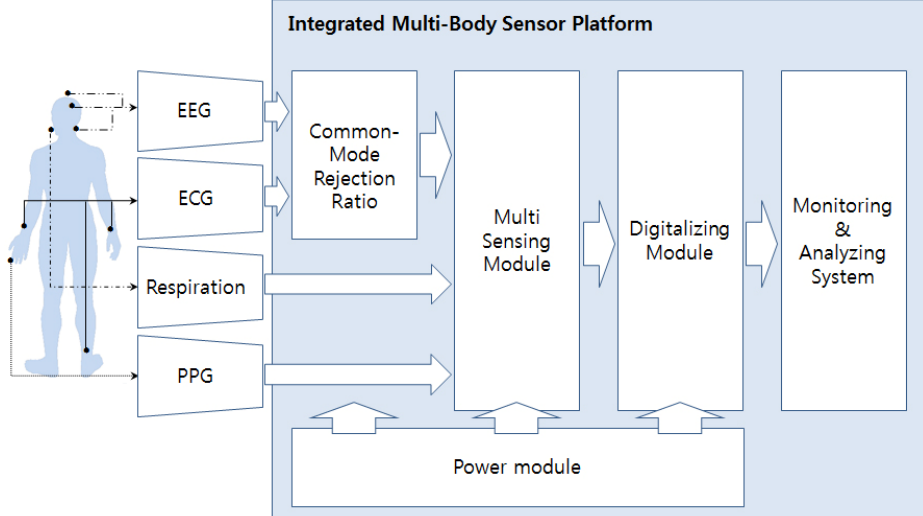
Figure 1. Structure of the integrated multi-body sensor